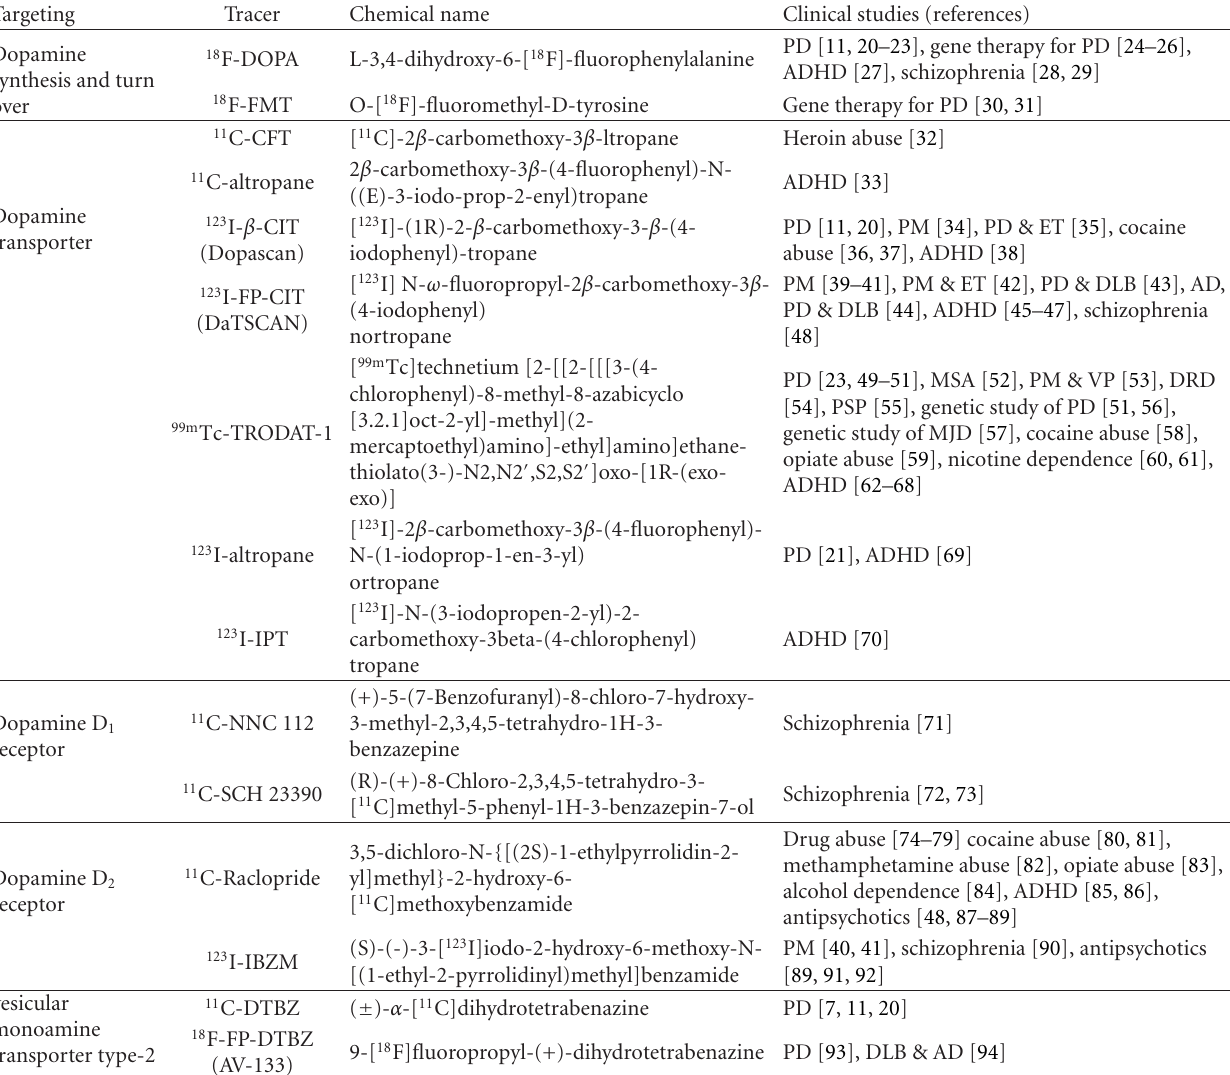
Table 1: Radiotracers available for targeting di ff erent steps in the process of dopaminergic neurotransmission and clinical applications. Targeting